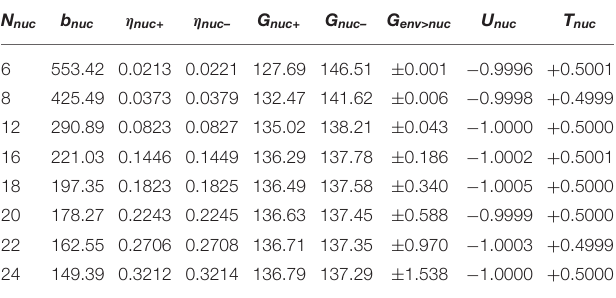
TABLE 3 | Stability of individual envelope